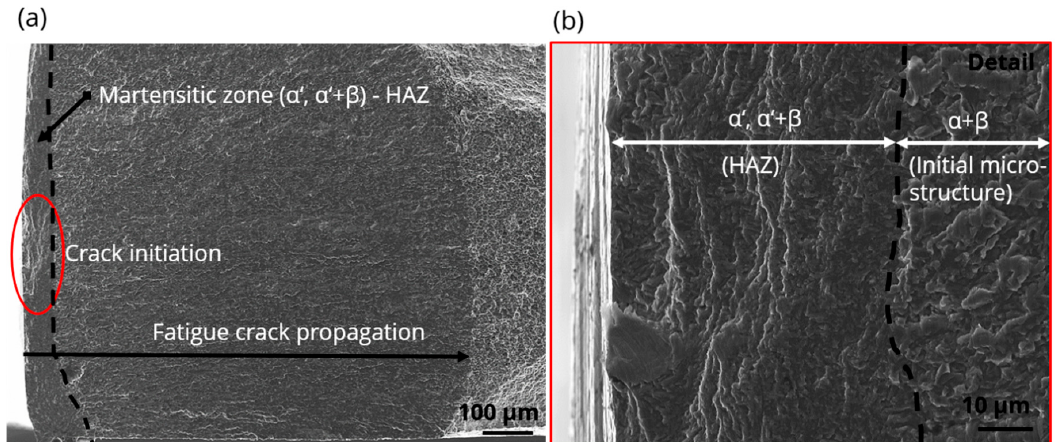
Figure 9. Fractography of a Ti-6Al_LC sample with as-cut surface condition failed at 200 MPa and 5.2 × 10 5 cycles: ( a ) SEM (SE) analysis of the fractured surface with identification of the martensitic zone; ( b ) The corresponding detailed view at the fatigue crack initiation point.